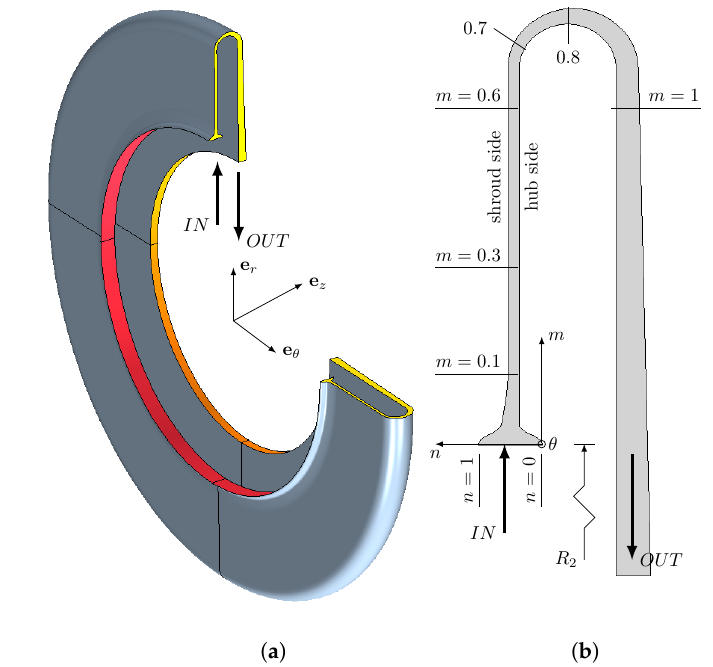
Figure 1. ( a ) An isometric view of the vaneless diffuser geometry with a cut-out to depict the side view profile; ( b ) side section view depicting inlet and outlet